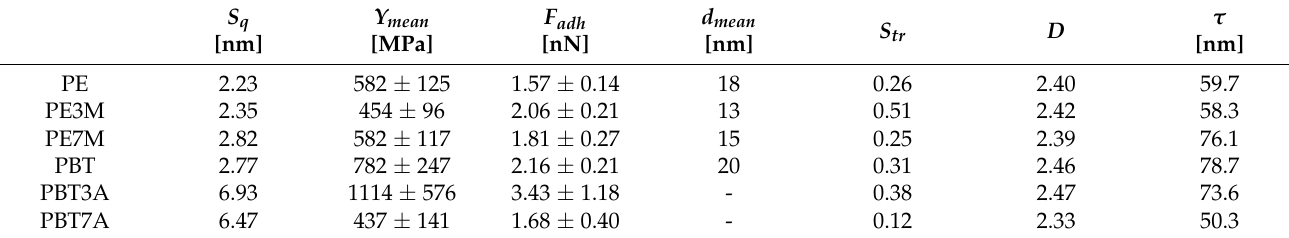
Table 4. Topographical and nanomechanical parameters of the surfaces of the fracture